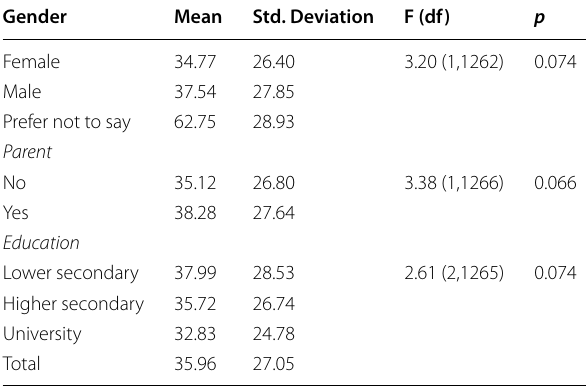
Table 3 Health-related quality-of-life by gender, parental status and